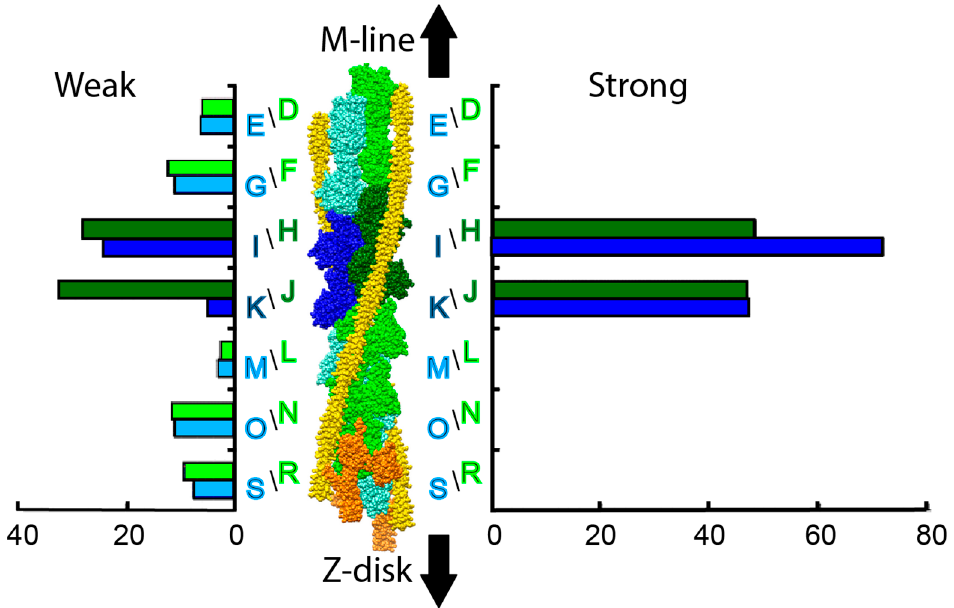
Figure 6. Myosin head binding to specific actin subunits on the 38.7 nm thin filament repeat in the Lethocerus flight muscle undergoing an isometric contraction. On the left weak attachments are shown; on the right are strong attachments. Actin subunits on the two long pitch strands are colored green and blue. The two target-zone actin subunits are in darker shades. Actin subunit designations correspond to the chain names in the coordinate files deposited in the Protein Data Bank, PDB – 2w49. From [34].